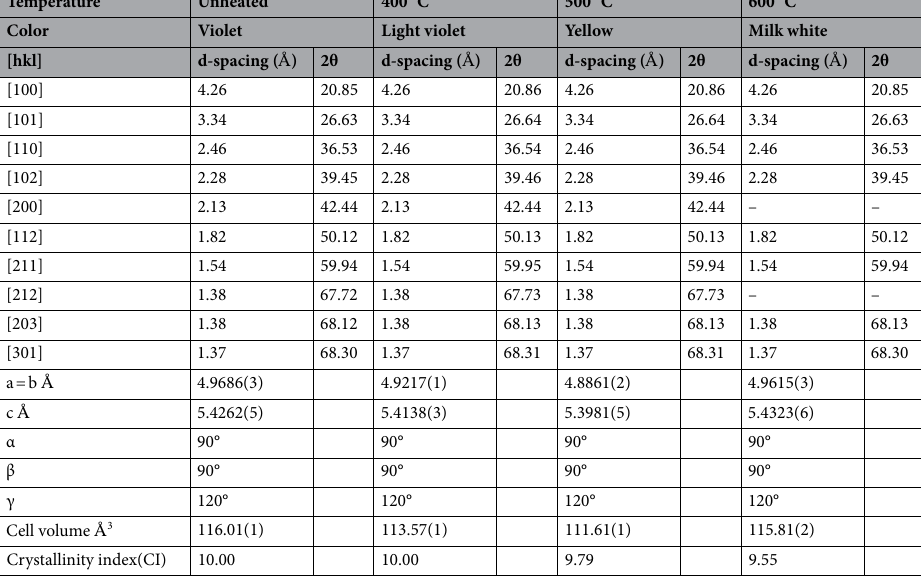
Table 1. XRD analysis data of samples under different heat treatment